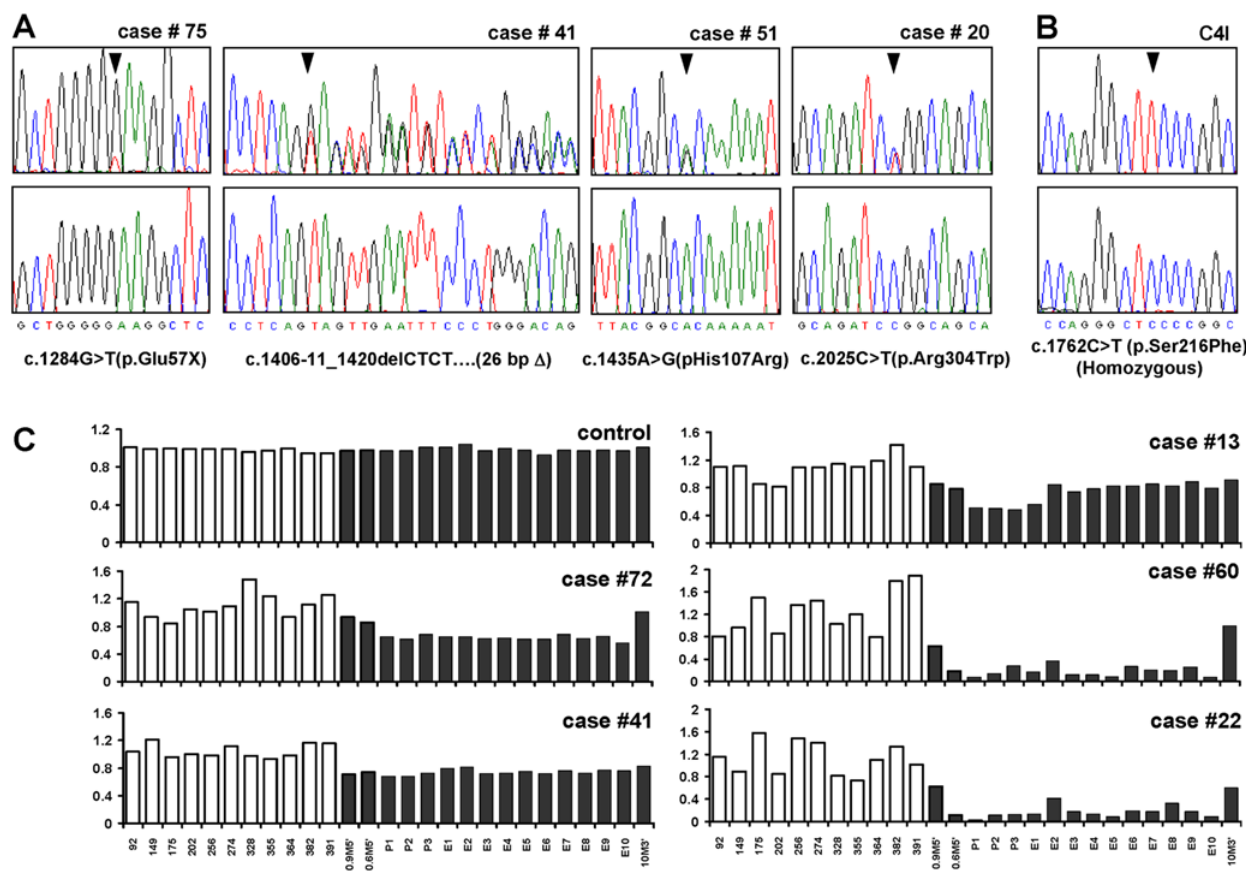
Figure 1. Somatic mutations and deletions of LKB1 in cervical tumors. (A) Representative chromatograms of primary tumors. (B) C4I cell line. Lower panels, control DNA samples from each patient (for C4I, human peripheral leukocyte DNA). Wild-type sequences are shown below. Chromatograms represent forward strand except case # 41 where reverse complement is shown to more clearly illustrate the deletion. Mutations are heterozygous except where indicated. (C) LKB1 deletions in primary cervical tumors by MLPA. Bars=relative signal intensity per probe. Sixteen probes (black) correspond to LKB1 locus on chromosome 19. Probe identifiers shown below. Probes 0.9M5 9 and 0.6M5 9 are , 900 and 600 kb 5 9 of locus (telomeric), while 10M3 9 is , 10000 kb 3 9 (centromeric); remaining 13 probes correspond to LKB1 noncoding/coding exons. White bars correspond to randomly selected probes from other chromosomes.